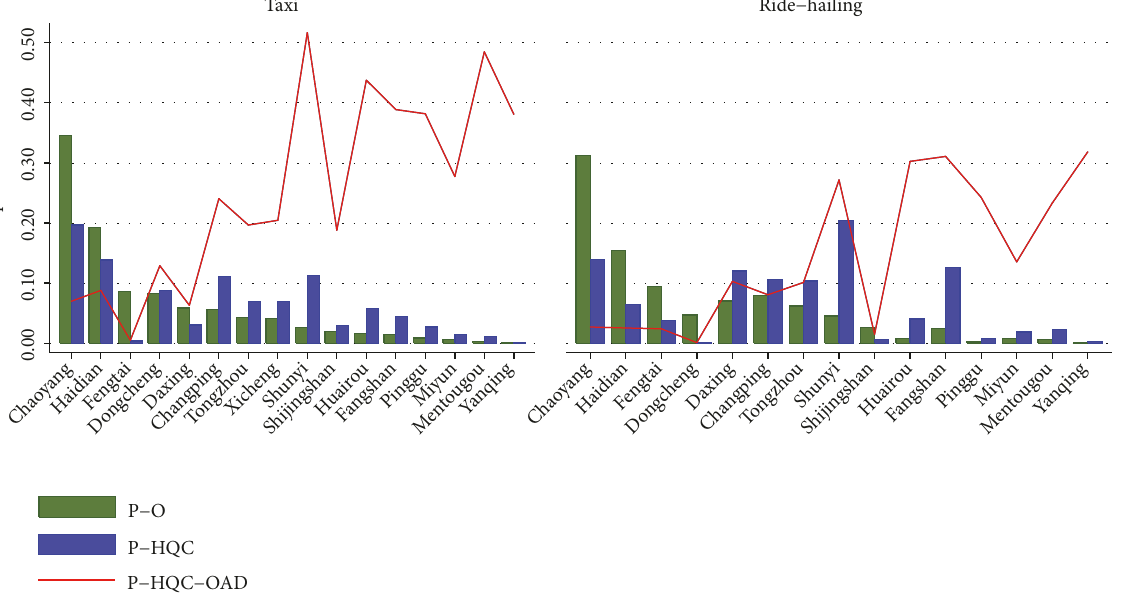
Figure 2: The distribution of orders and HQC in different administrative districts.